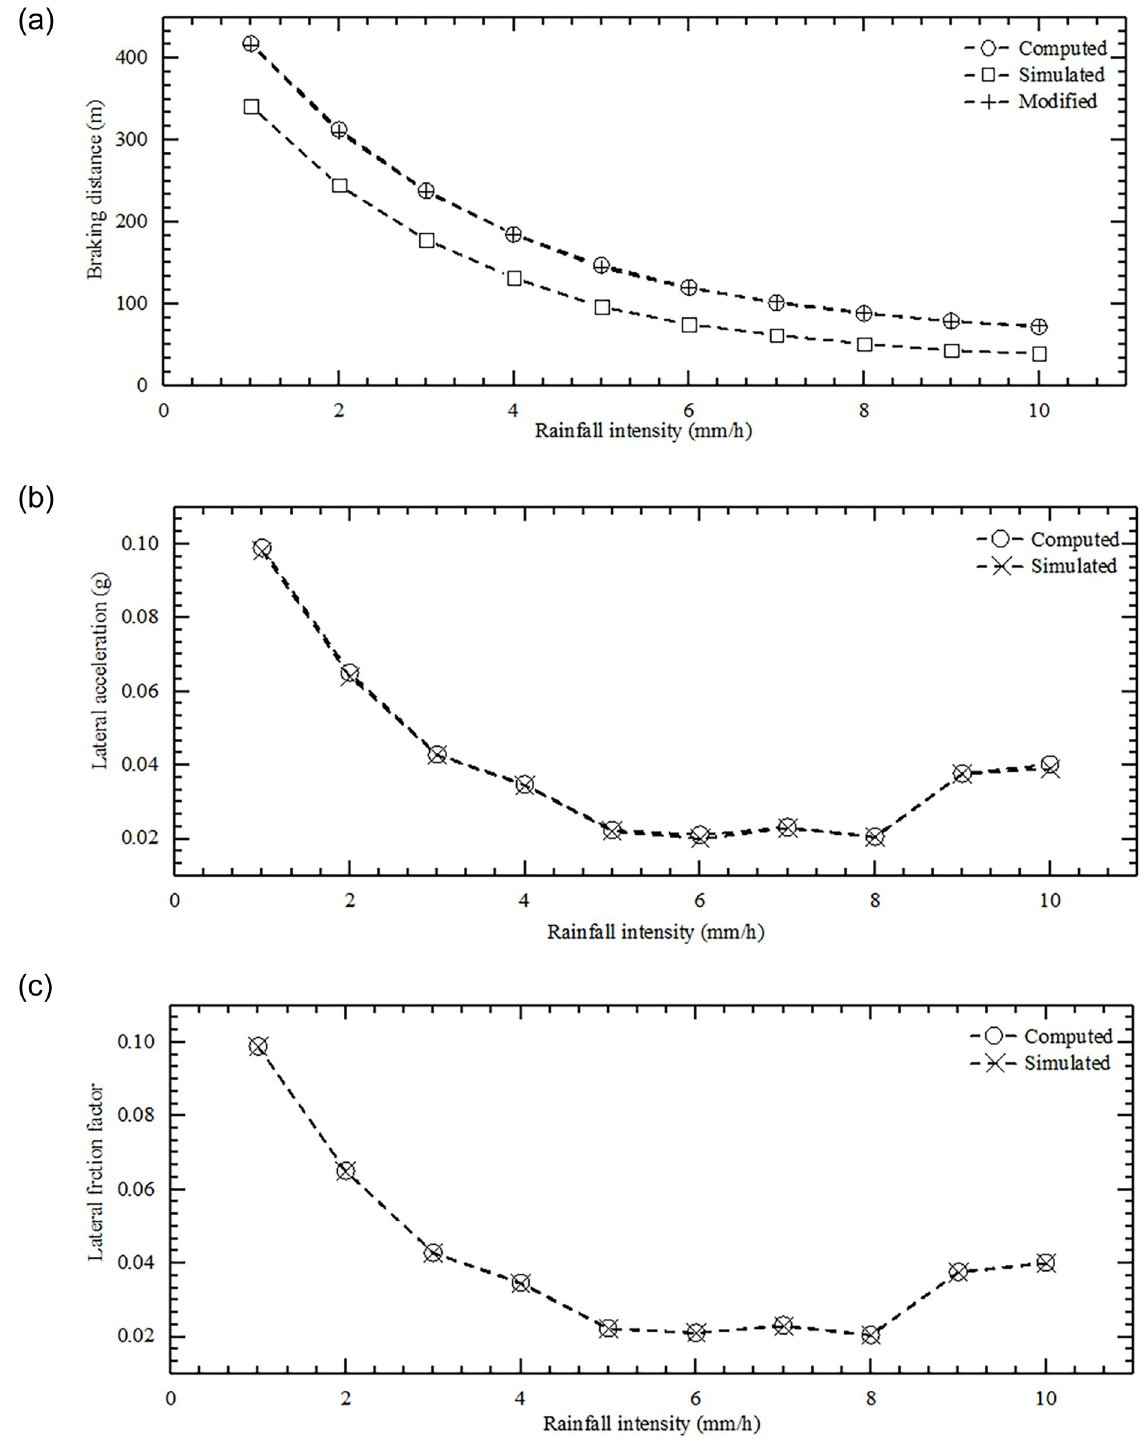
Fig 4. Comparison of the computed and simulated results. (a) Computed, modified, and simulated braking distance; (b) Computed and simulated lateral acceleration; (c) Computed and simulated lateral friction factor.